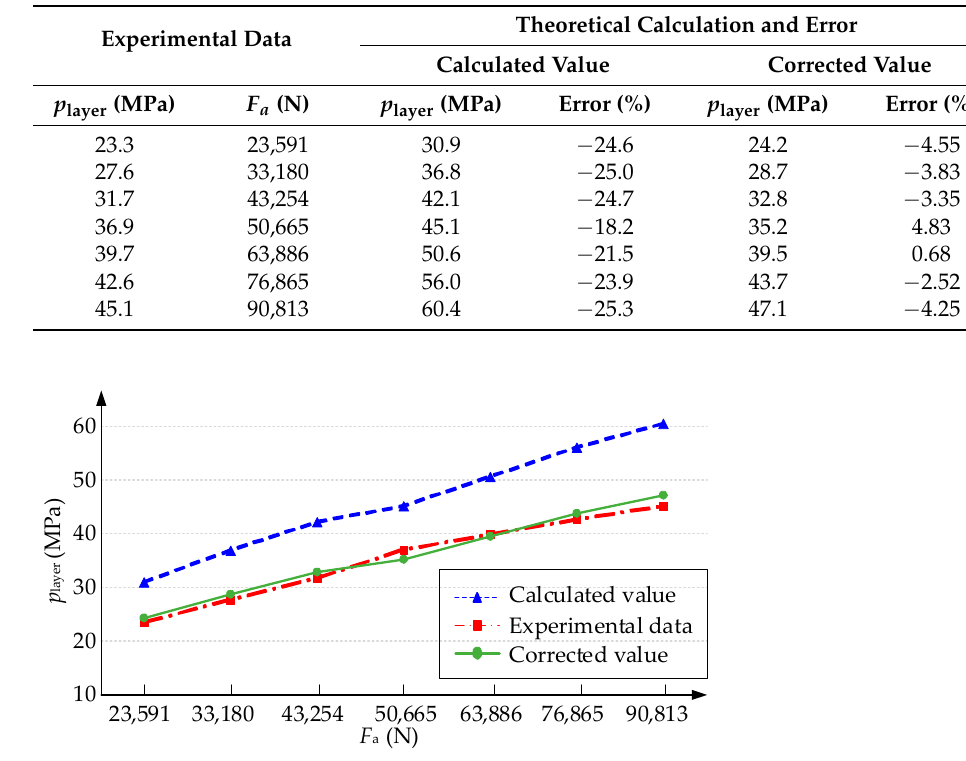
Table 9. Data error of interlayer test of connector contact sealing theory verification.